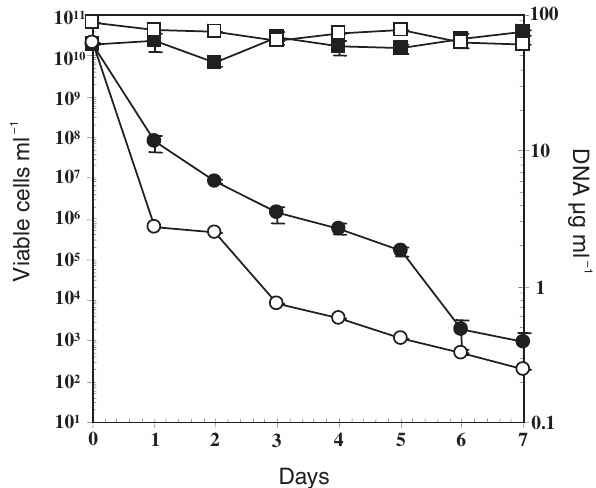
Figure 2. Quantity of extractable DNA in response to the absence of sulfate. Number of viable cells ( (cid:4) , (cid:2) ) and DNA concentrations ( (cid:5) , (cid:3) ) from F. acidarmanus in 0.1% yeast extract acidified to pH 1.0 with either H 2 SO 4 ( (cid:4) , (cid:5) ) or HCl ( (cid:2) , (cid:3) ). Values represent the means from three independent trials. Error bars represent the standard error of the